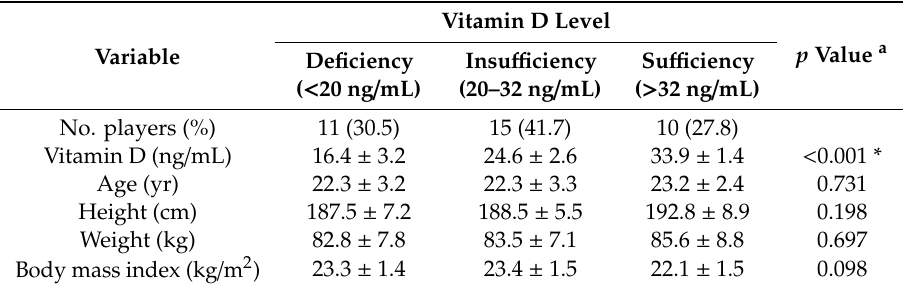
(Table 2). In the non-dominant side, no significant correlations were noted between vitamin D level and knee or ankle isokinetic strengths (all p > 0.05, Table 2). Table 1. Players’ demographics by vitamin D status.